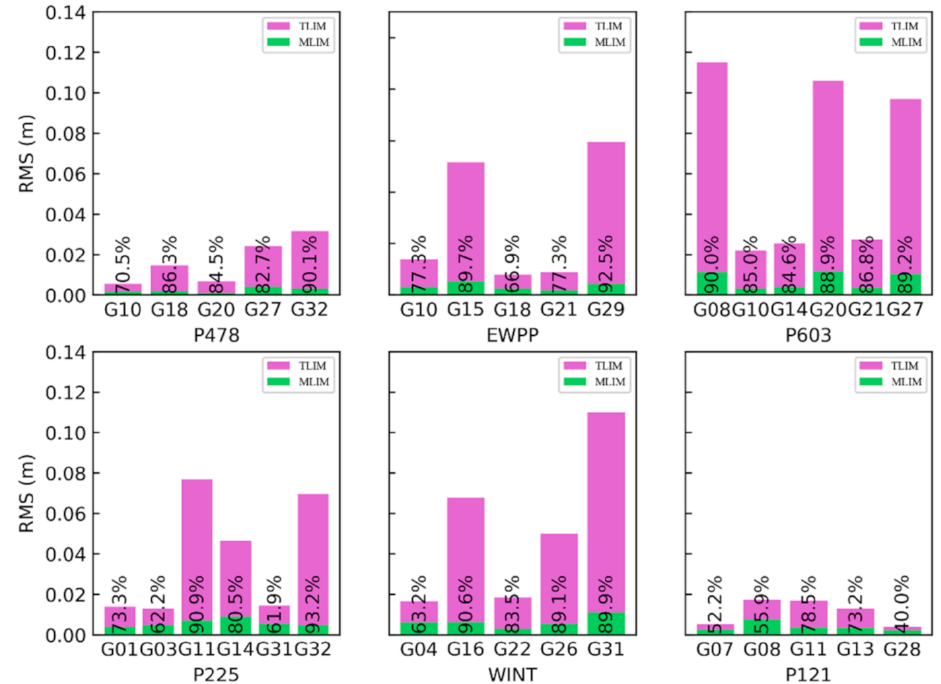
Figure 11. RMS errors of the DD tropospheric delay using modified and traditional methods for all non-reference satellites at all rover stations. The percentages on each bar are the improvements of the MILM with respect to the